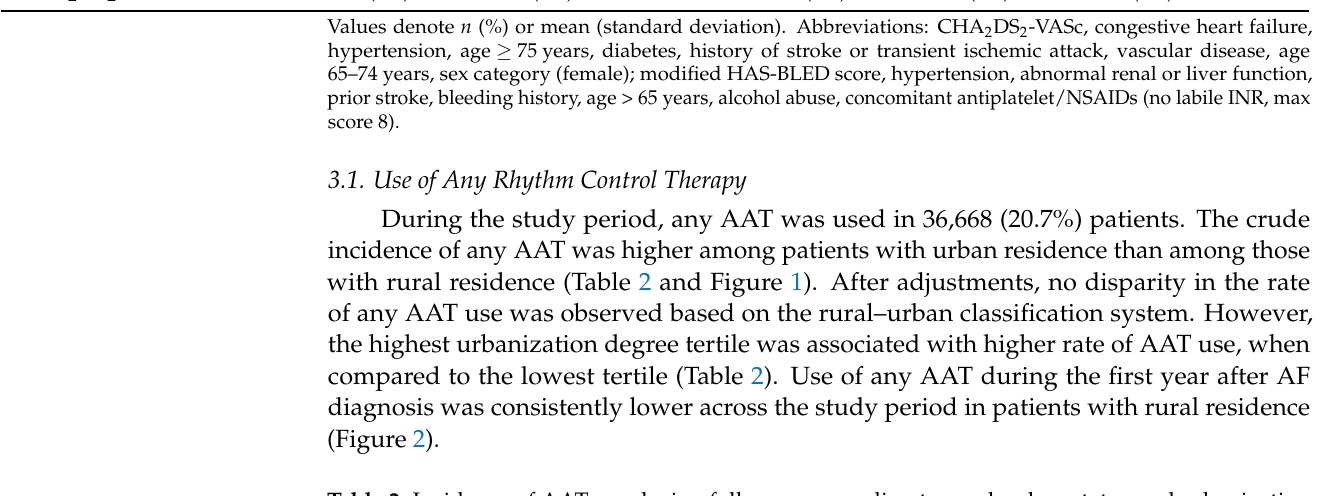
Table 2. Incidence of AAT use during follow-up according to rural–urban status and urbanization degree